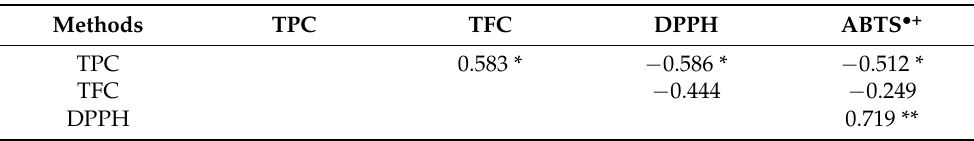
Table 3. Correlation coefficient (r) values estimated from correlation analysis between values of TPC, TFC, DPPH, and ABTS • + of bee bread samples.